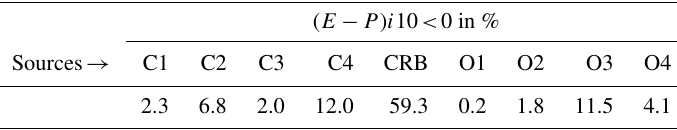
Table 2. Moisture contribution from the sources to the CRB (%).